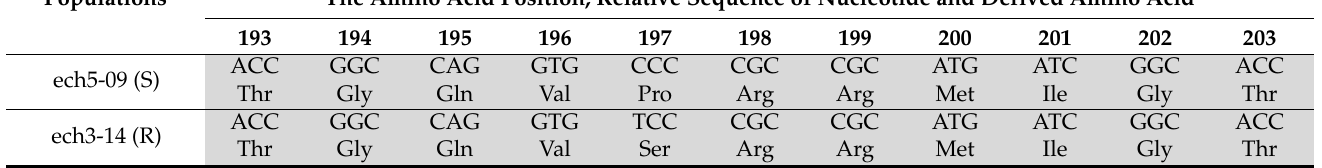
Table 4. Alignment of sequences for the ALS gene. In bold and highlighted, the nucleotides encoding Pro197 in the susceptible population (S) and the mutation in the resistant ones. Populations